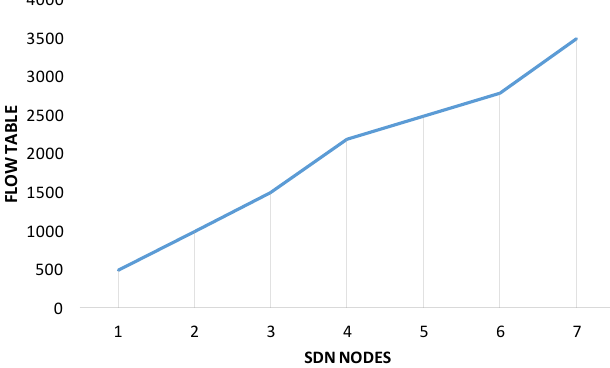
Figure 11. SDN domains and flow-tables.